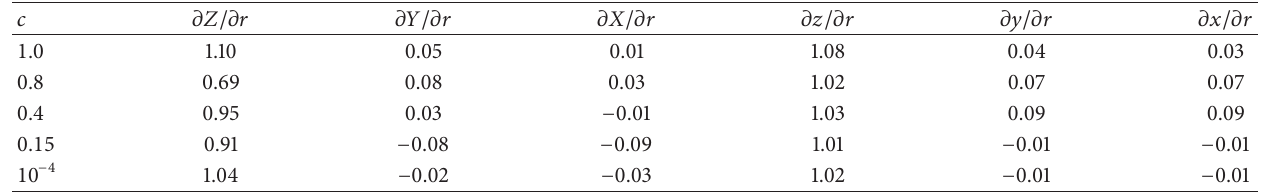
Table 4: Sensitivity estimates of fast and slow variables with respect to parameter 𝑟